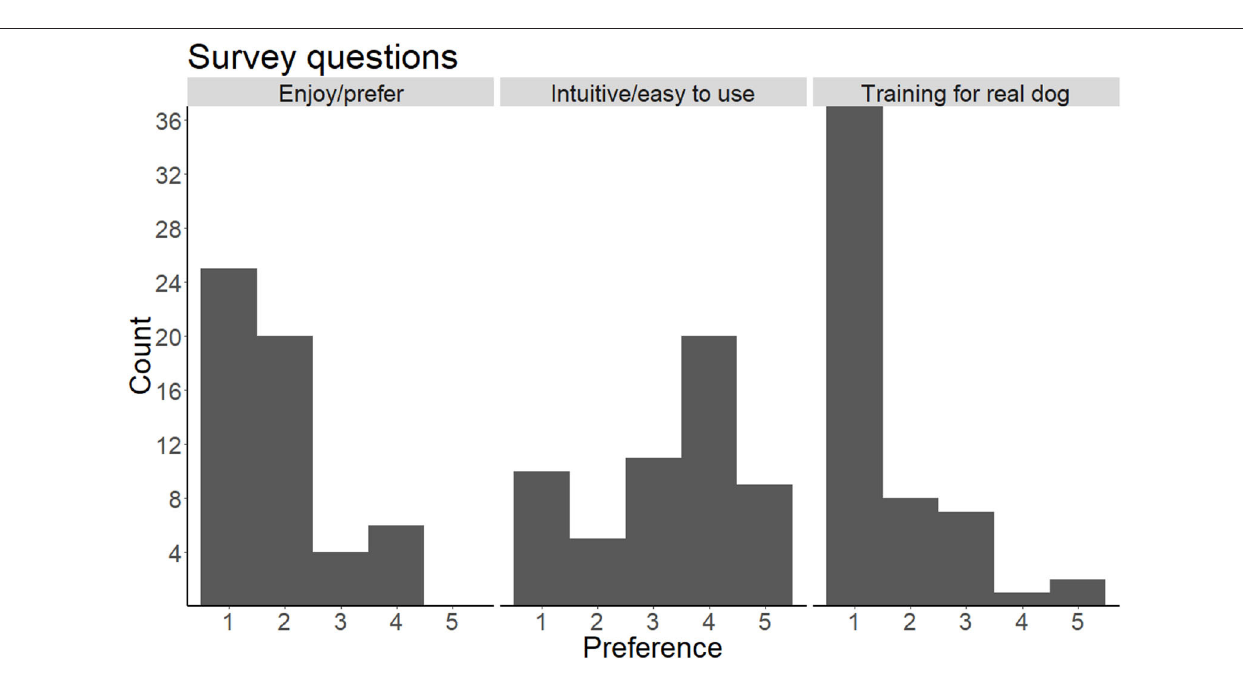
FIGURE 7 | Ratings on a 5-point scale for three survey questions. A rating of 1 represents a strong preference for the RBI mode, while 5 represents a strong preference for the CMD